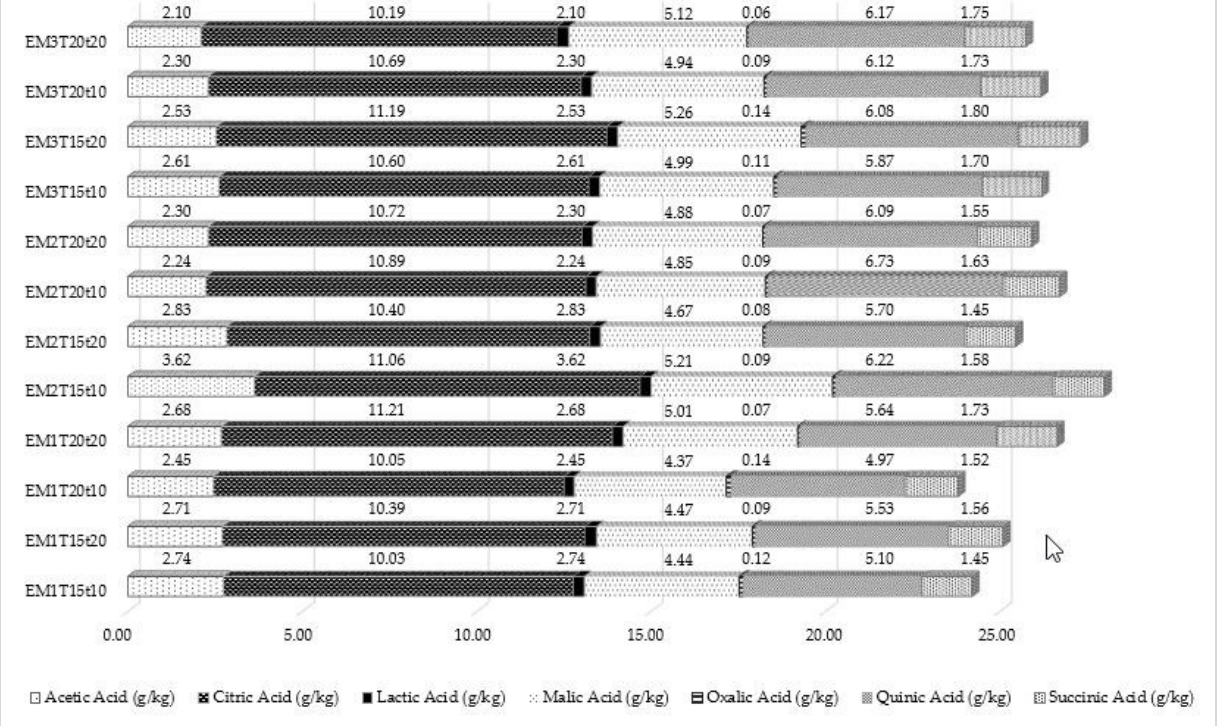
Figure 3. Average organic acid content of coffee beans with prolonged mucilage fermentation.